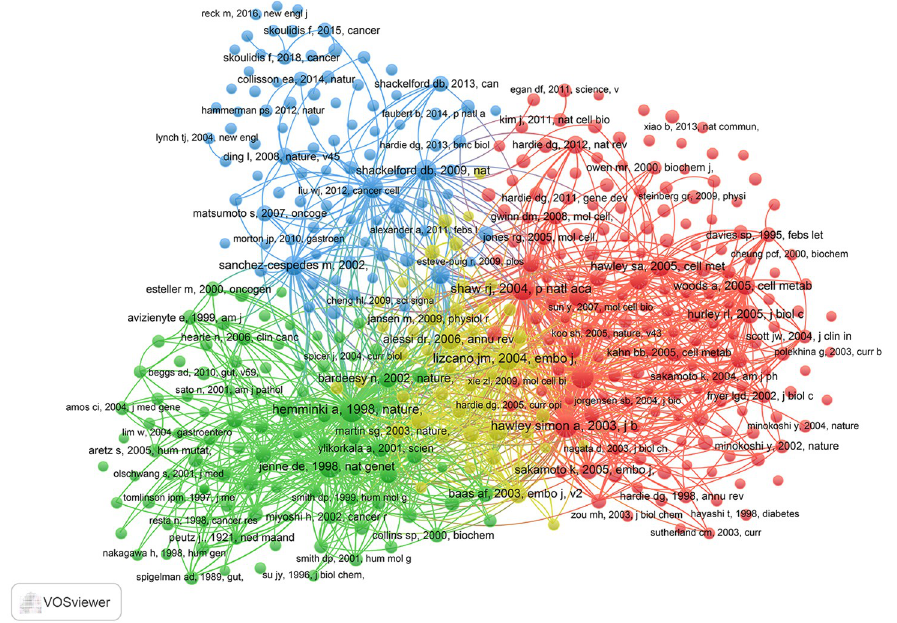
Fig 7. Co-cited references in LKB1